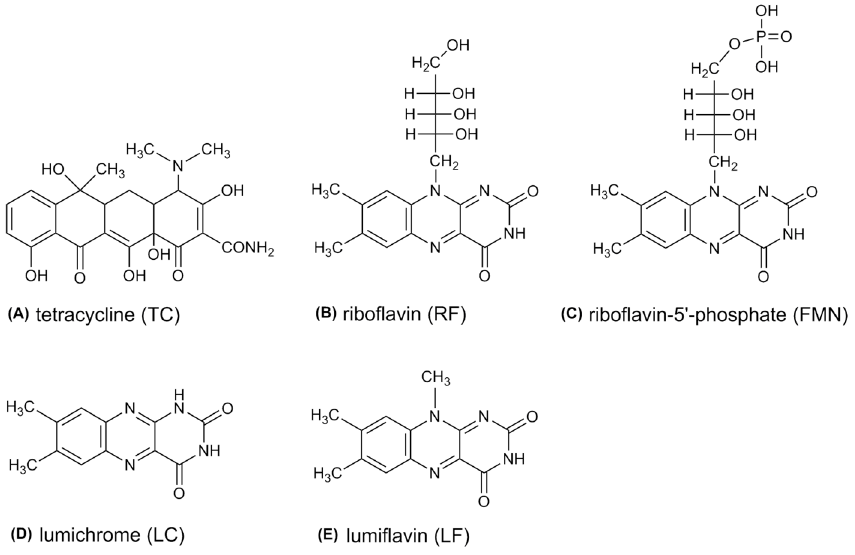
Figure 1. The chemical structure of ( A ) tetracycline (TC), ( B ) riboflavin (RF), ( C ) riboflavin-5 ′ - phosphate (FMN), ( D ) lumichrome (LC), and ( E ) lumiflavin (LF). (FMN), ( D ) lumichrome (LC), and ( E ) lumiflavin